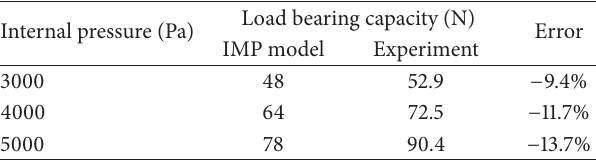
Table 5: Dependence of maximum bearing force on mesh